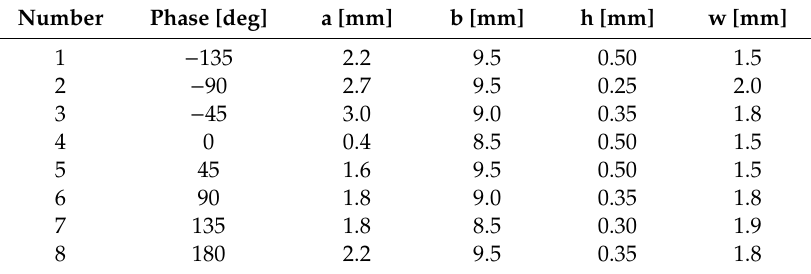
Table 1. Geometry parameters of unit cells in a period (f = 7.0